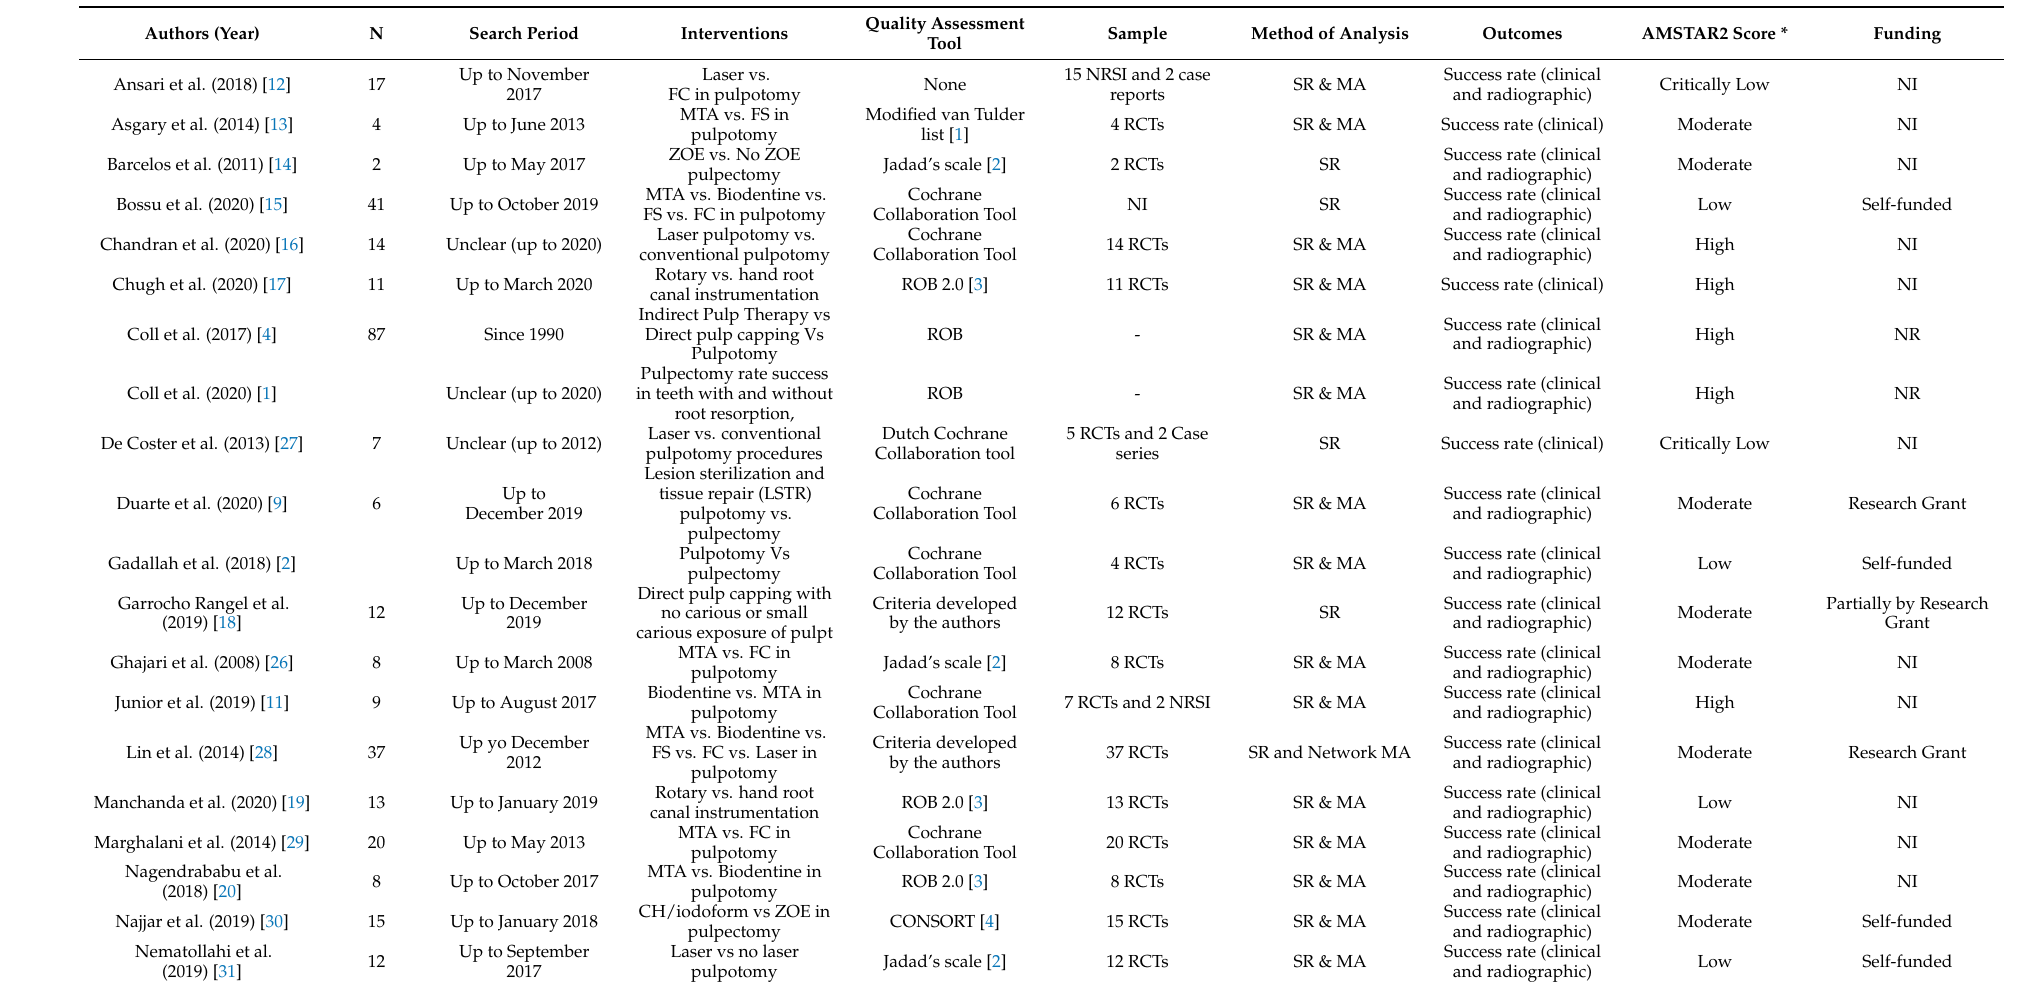
Table 1. Characteristics of included